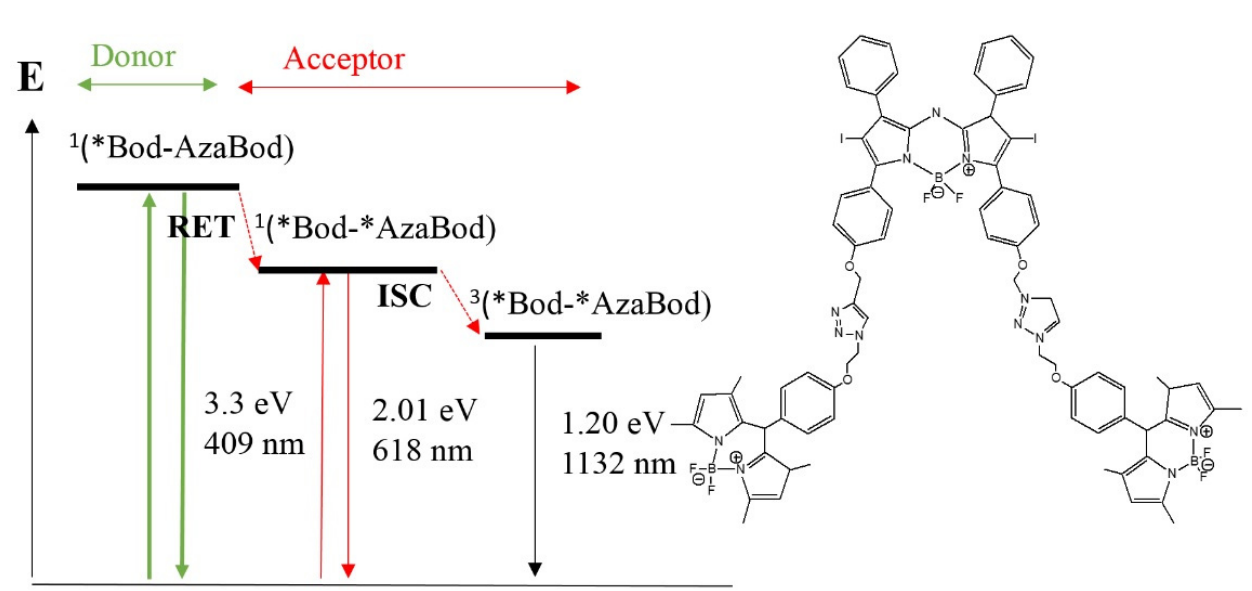
Figure 29. Example of resonance energy transfer (RET) and ISC for a BODIPY/aza-BODIPY based